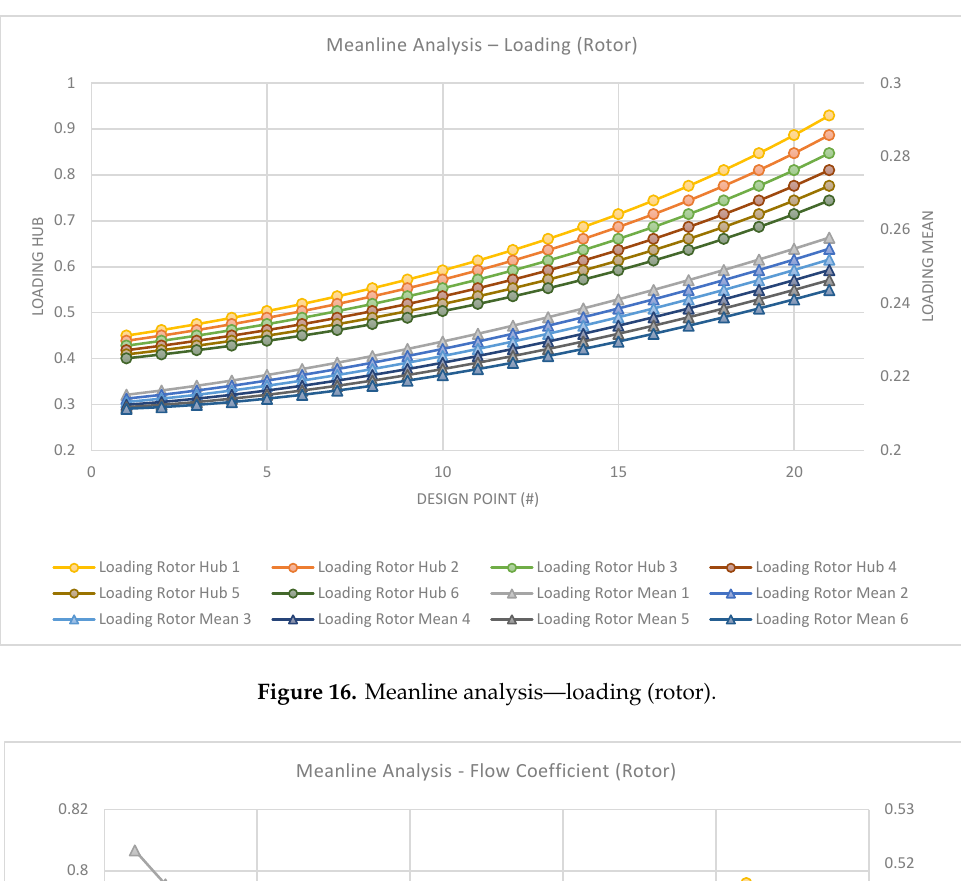
Figure 15. Meanline analysis—DeHaller number (Rotor).